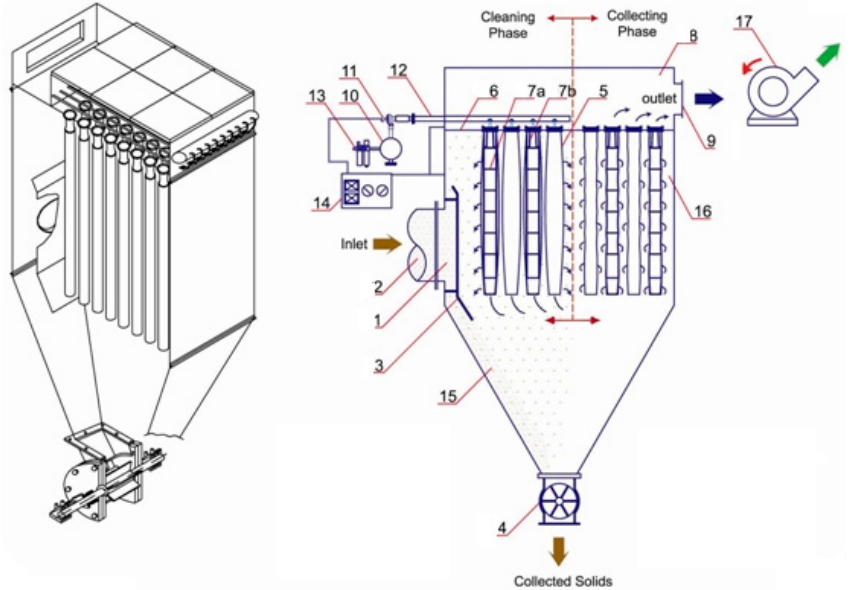
Figure 2. Bag filter example: 1. Separation chamber; 2. Dust laden gas inlet; 3. Baffle plate; 4. Rotary valve; 5. Filter bags; 6. Cell plate; 7. Filter Cage and Venturi; 8. Clean gas chamber; 9. Clean gas outlet; 10. Compressed air tank; 11. Diaphragm valve; 12. Blow pipe, 13. Water trap; 14. Sequential controller; 15. Falling dust; 16. Filtration chamber; 17. Suction fan [38].